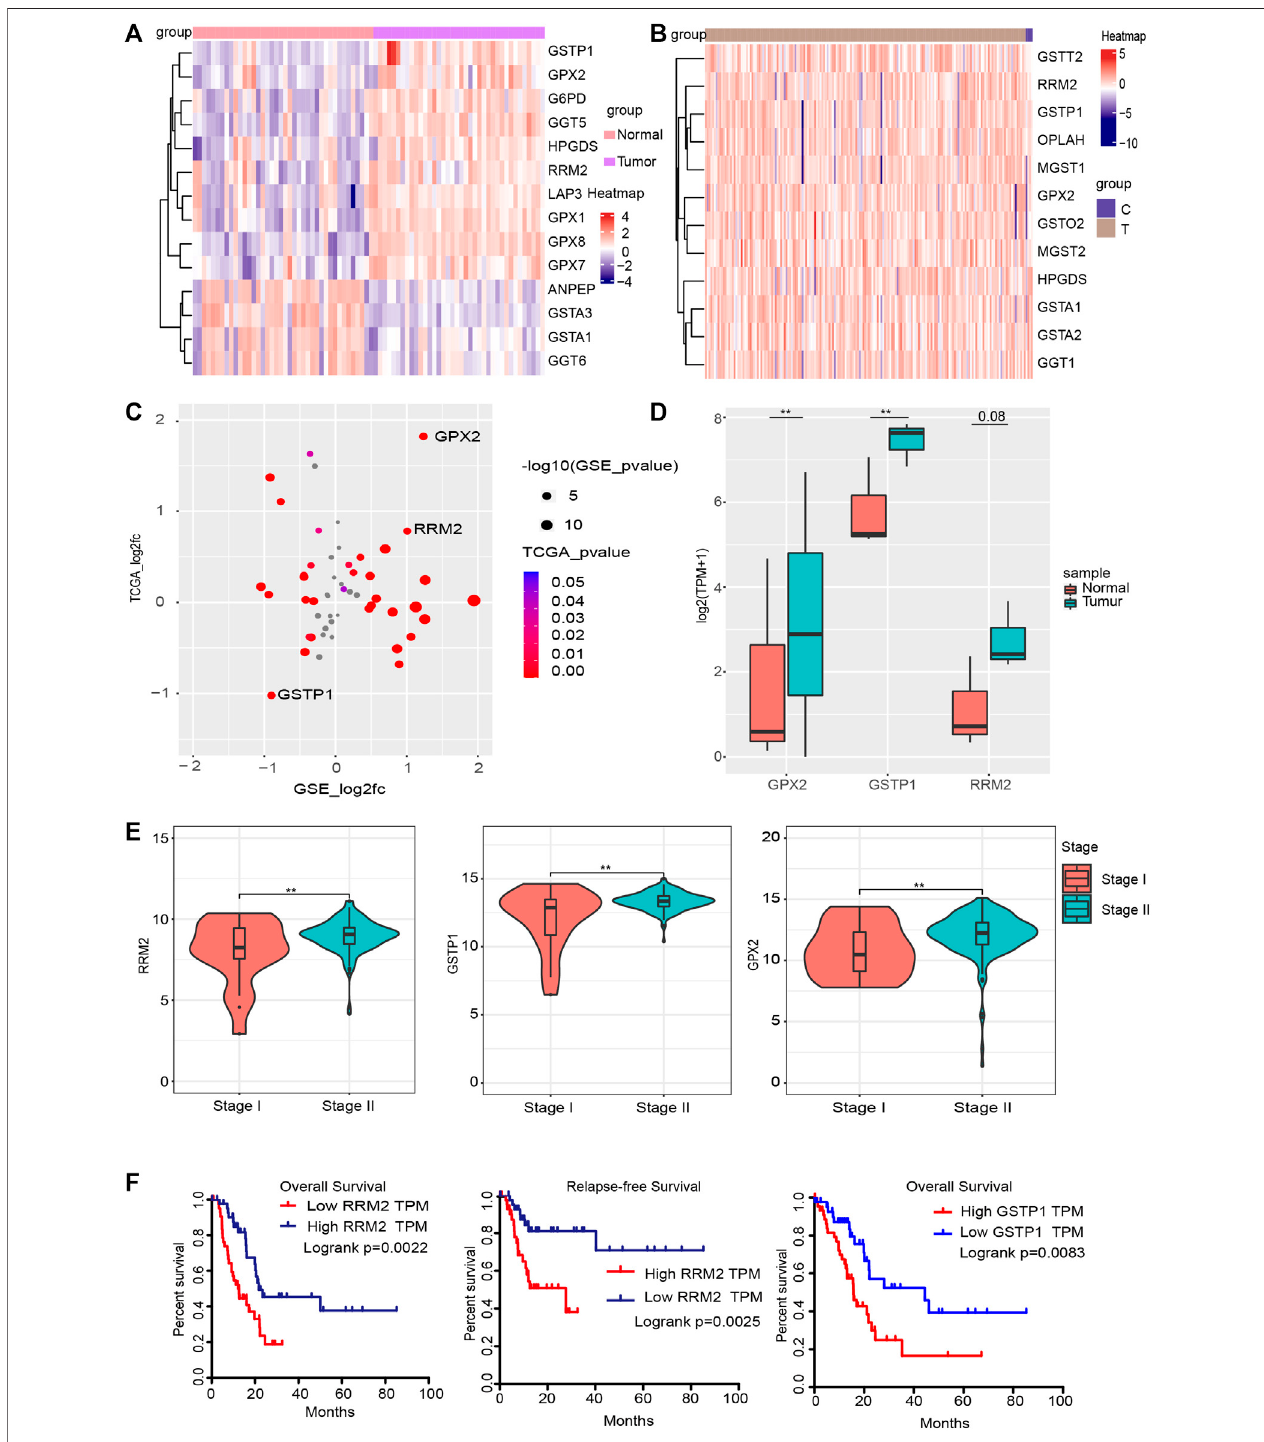
FIGURE 5 | Glutathione signaling pathway genes are associated with PC stage. (A,B) Heatmap of differentially expressed glutathione pathway genes in the GSE15471 and TCGA datasets. (C) Four quadrantdiagram of the glutathione genes that differ between the GSE15471 and TCGA datasets. (D) The expression level of RRM2, GSTP1andGPX2inourownRNA-seq data(** p value < 0.01). (E) IntheTCGAdata,theRRM2,GSTP1andGPX2genesweresigni fi cantlydifferentlyexpressed in different stages of PC ( p < 0.05). (F) Survival analysis and Relapse-free Survival analysisof RRM2 (left and middle) in TCGA dataset; survival analysis of GSTP1 in TCGA dataset